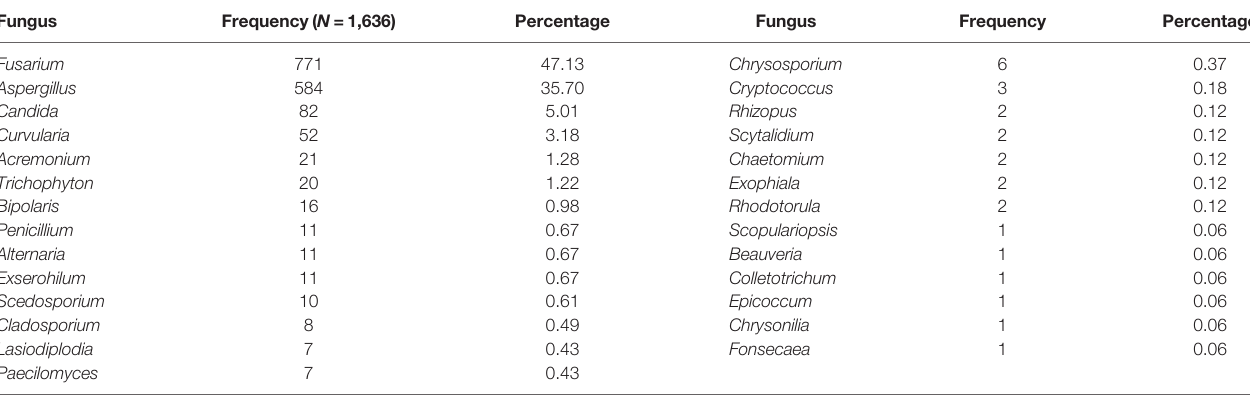
TABLE 4 | The spectrum and frequency of various fungi isolated from patients with con fi rmed microbial keratitis and identi fi ed at the genus level during 1990 to 2020 (1,636 out of 2,016 isolates have been identi fi ed). Fungus